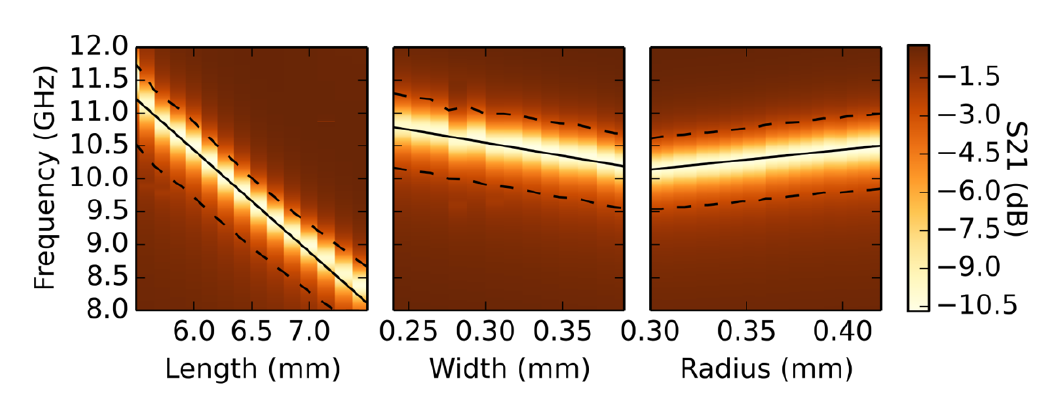
Figure A10. Composite simulated results of spirals with parametric sweep of arm length, arm width, and center radius. The regions outside the dotted black lines imply filtering above − 3 dB, the regions within the dotted black lines imply filtering below − 3 dB, the solid black lines denote the center frequency of the S 21